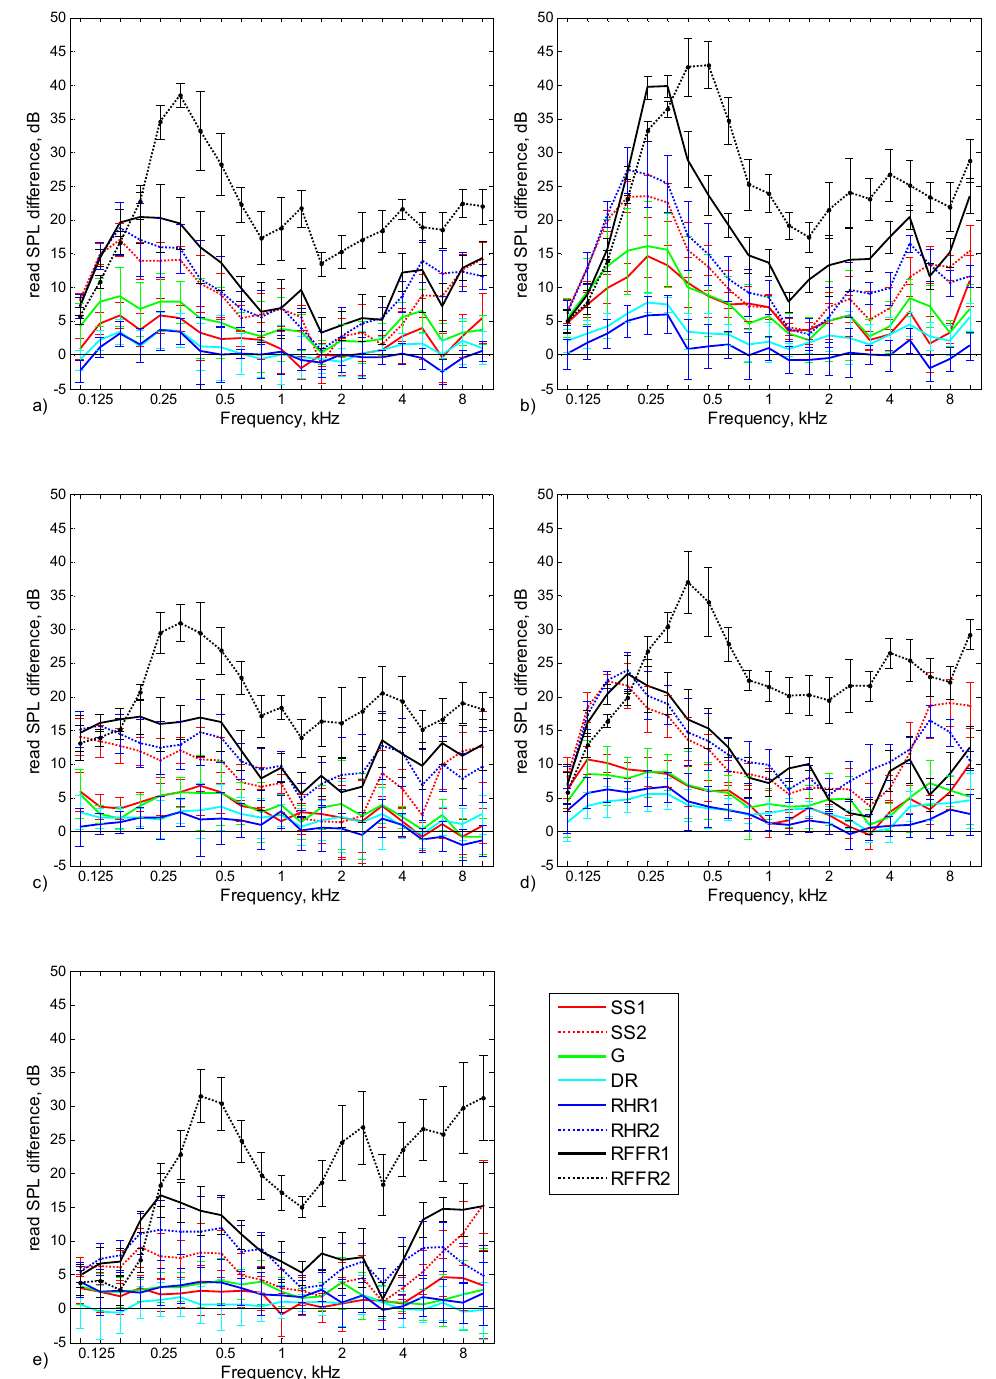
Figure 4. Difference between SPLs in 1/3 octave bands under earmuffs used in combination with OPPE and without OPPE: ( a ) EM1; ( b ) EM2; ( c ) EM3; ( d ) EM4; and ( e ) EM5. SS—safety spectacles, G—goggles, DR—disposable respirator, RHR—reusable half respirators, RFFR—reusable full face respirators. Error bars show standard deviations.